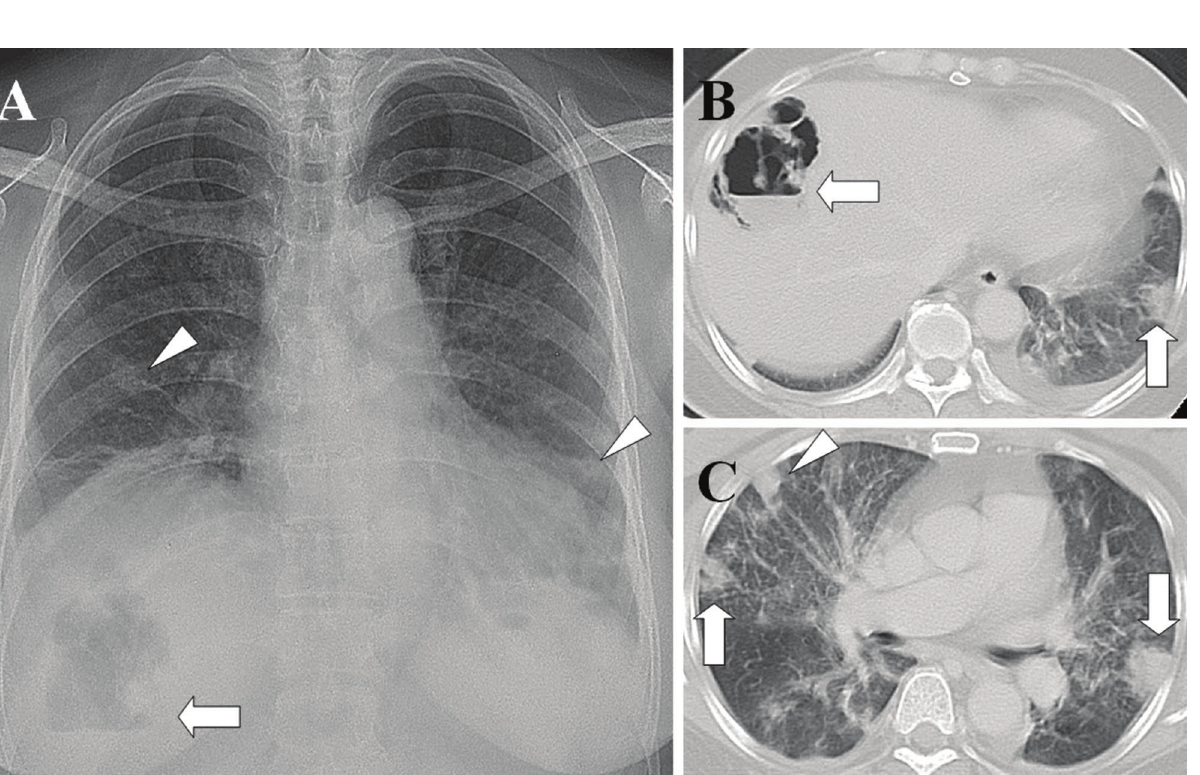
Figure 1 - Liver abscess with septic pulmonary emboli. (A) A chest radiograph shows an air-fluid level in the right upper abdomen (arrow) and multiple nodular opacities in the bilateral lungs (arrowheads). (B) A CT scan shows a gas-forming liver abscess (arrow) and a peripheral wedge-shaped opacity abutting the adjacent pleura (arrow). (C) A lung window of a cross-sectional CTscan shows two peripheral wedge-shaped opacities abutting the adjacent pleura (arrows) and a peripheral nodule with a feeding vessel (arrowhead). The patient was a 61-year-old diabetic woman whose blood and aspirate abscess cultures were positive for Klebsiella pneumoniae .